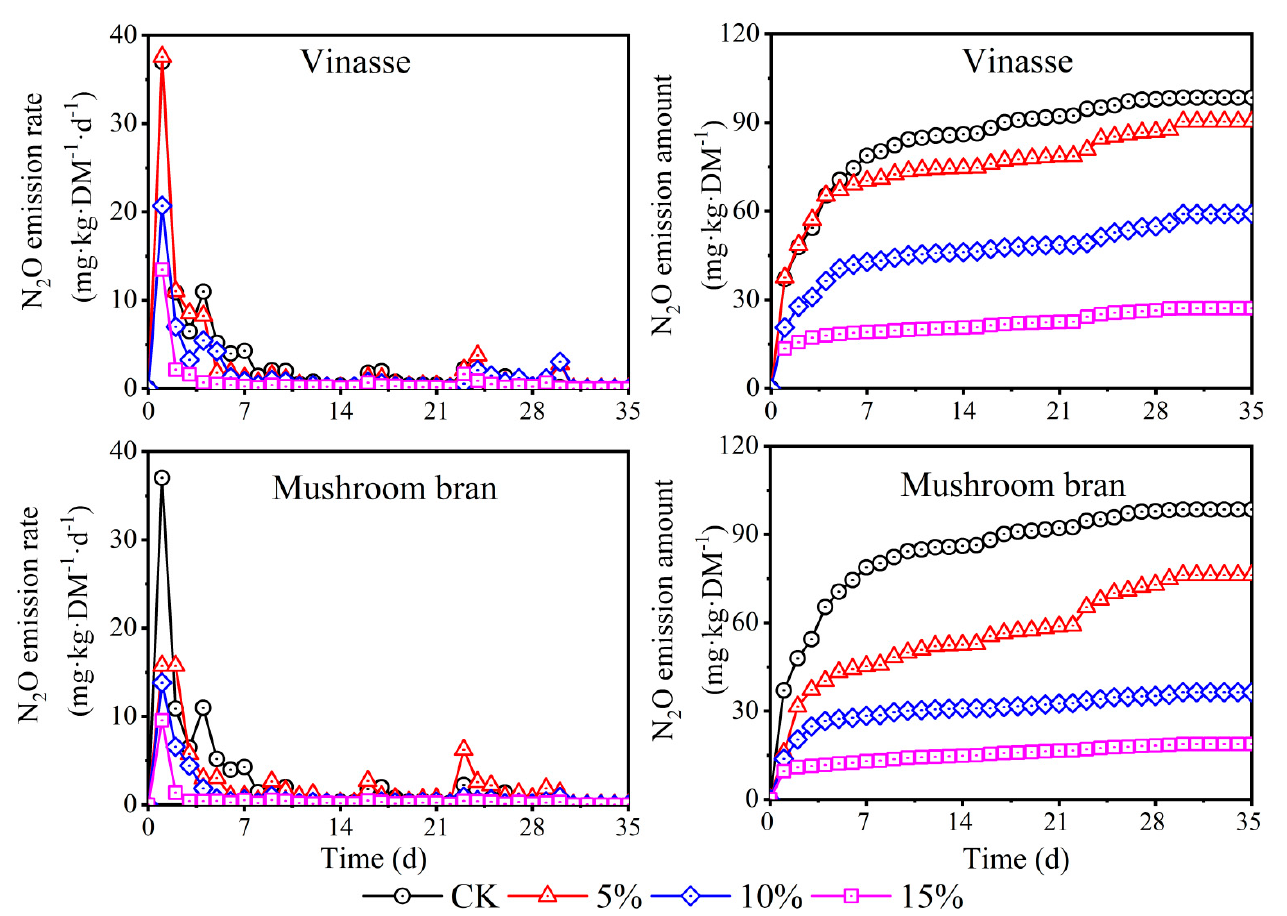
Figure 5. The emission variation of N 2 O during composting period.